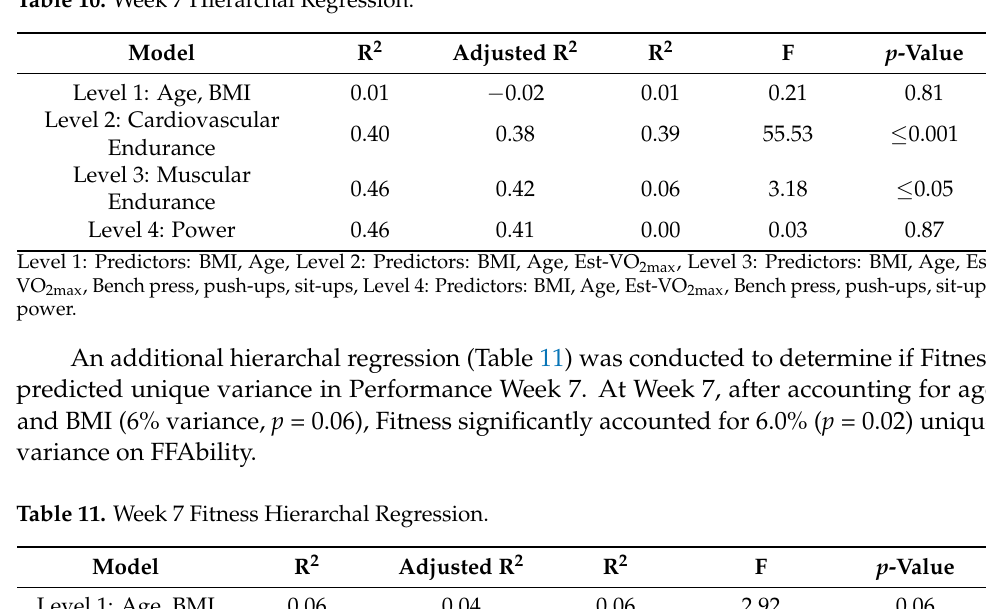
Table 10. Week 7 Hierarchal Regression.